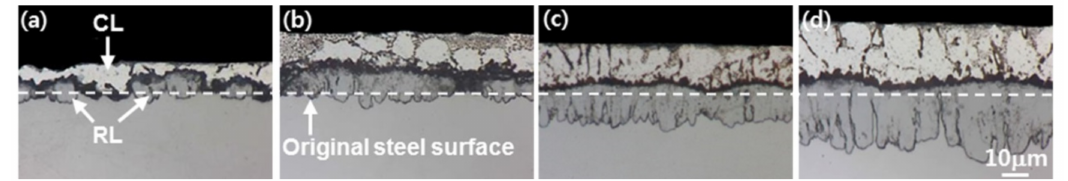
Figure 9. Cross-sectional light micrographs of steel hot dipped for various times: ( a ) 20 s, ( b ) 30 s, ( c ) 60 s, and ( d ) 120 s. RL: reaction layer. CL: coating